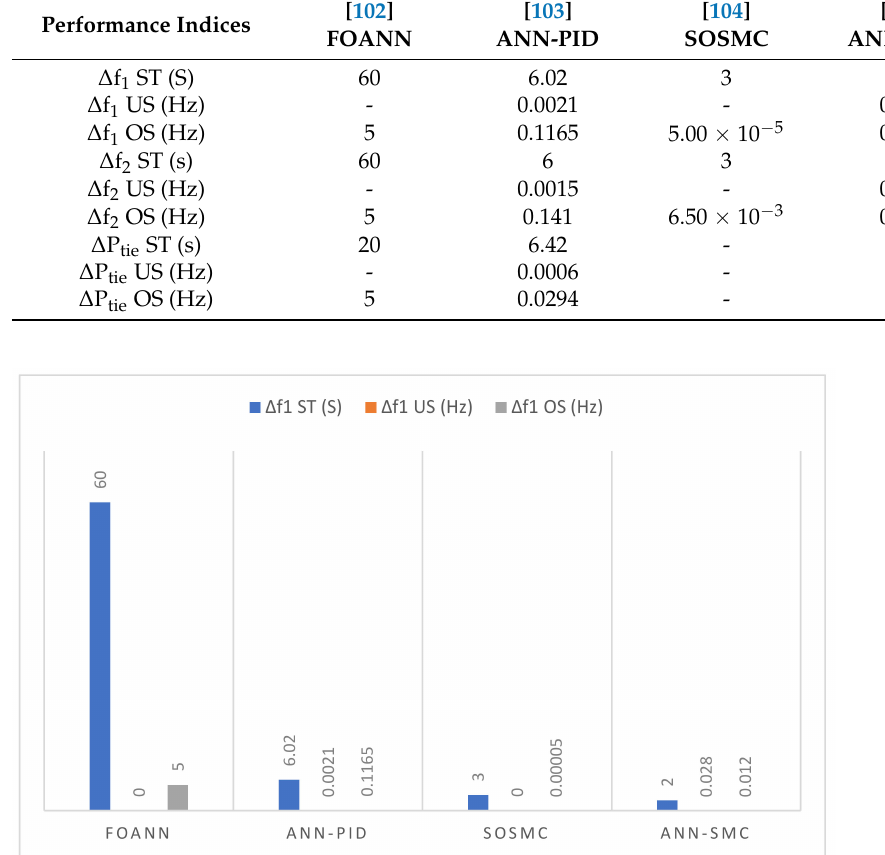
Figure 13. Frequency Deviation for Interconnected